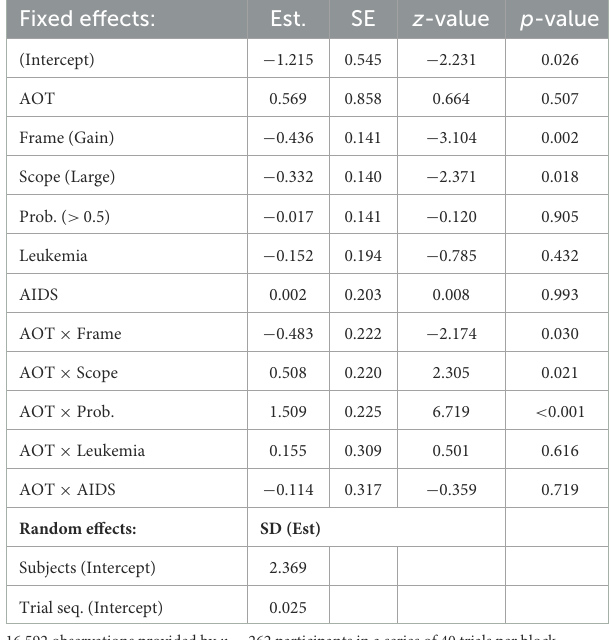
TABLE 8 Experiment 2: Generalized linear mixed model, Interactions: actively open-minded